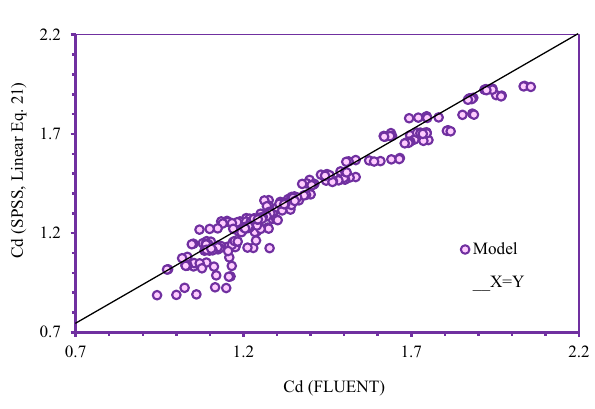
Fig. 16 Scatter plot of discharge coefficients obtained from of Fluent and Eq.